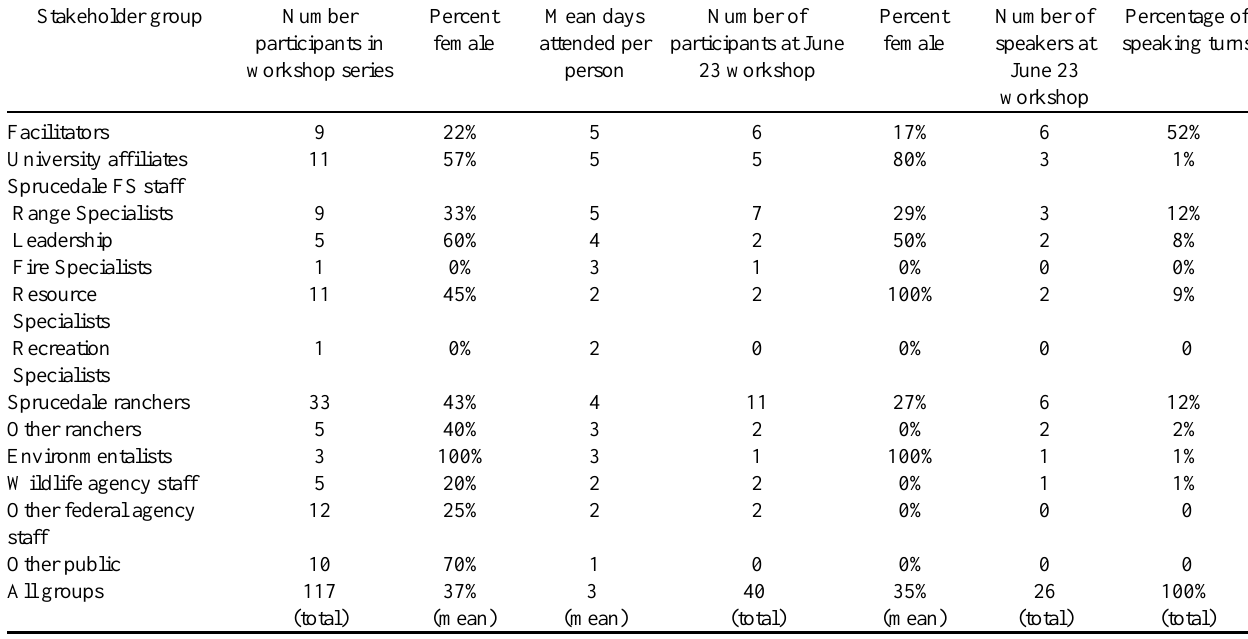
Table 2 . Stakeholder participation in the series of workshops (left three columns) compared to participation in the workshop analyzed in this study (right four columns). Stakeholder groups are arranged in order of mean days attended per person, which loosely represents each stakeholder group’s commitment to the series of workshops. “Number of speakers” is the number of participants who spoke during recorded workshop discussions. A “speaking turn” was counted each time a new speaker started talking or when a speaker changed